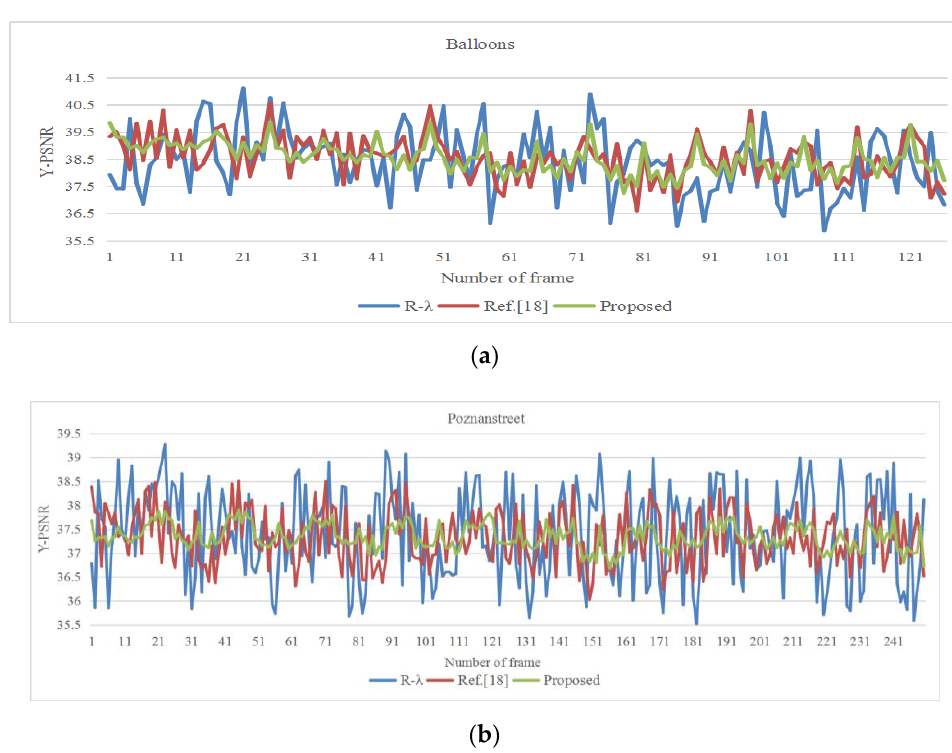
Figure 3. Experimental results of sequences: ( a ) “Balloons”, and ( b ) “Poznanstreet”.